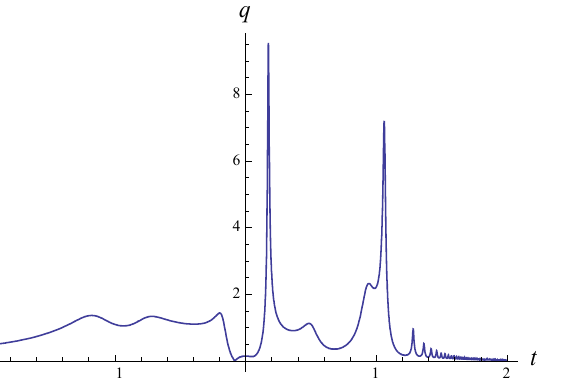
Figure 7. Profile at the position x = 0 of space–time of dynamical evolution of solution determined by Equation (95) with κ 1 ( 0 ) = 0.5, κ 2 ( 0 ) = − 1, α = t − 1, β = 1, γ = t + 1 and δ ( t ) = i .